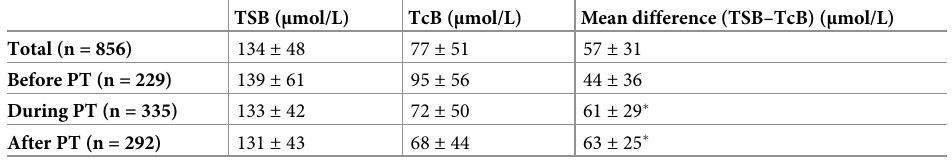
Table 1. Total serum bilirubin and transcutaneous bilirubin levels. TSB ( μ mol/L) TcB ( μ mol/L) Mean difference (TSB–TcB) ( μ mol/L) Total (n = 856) 134 ± 48 77 ± 51 57 ± 31 Before PT (n = 229) 139 ± 61 95 ± 56 44 ± 36 During PT (n = 335) 133 ± 42 72 ± 50 61 ± 29 � After PT (n = 292) 131 ± 43 68 ± 44 63 ± 25 � PT, phototherapy; TSB, total serum bilirubin; TcB, transcutaneous bilirubin, 17.1 μ mol/L = 1 mg/dL bilirubin. Data are represented as mean ( ± SD). � P < 0.05 before PT versus during and after